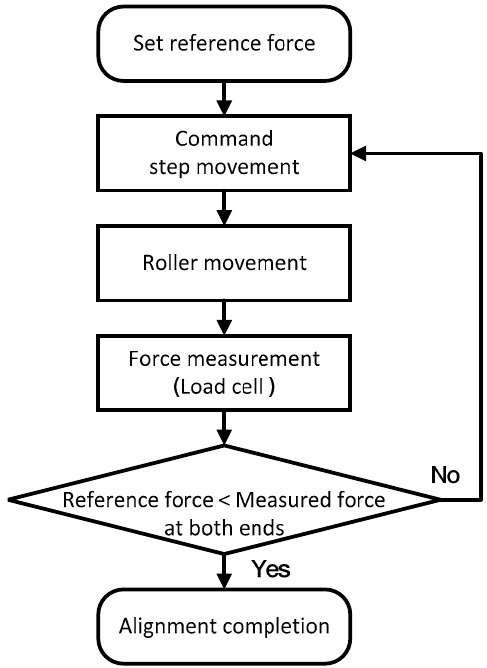
Figure 10. Flow chart for automatic alignment.